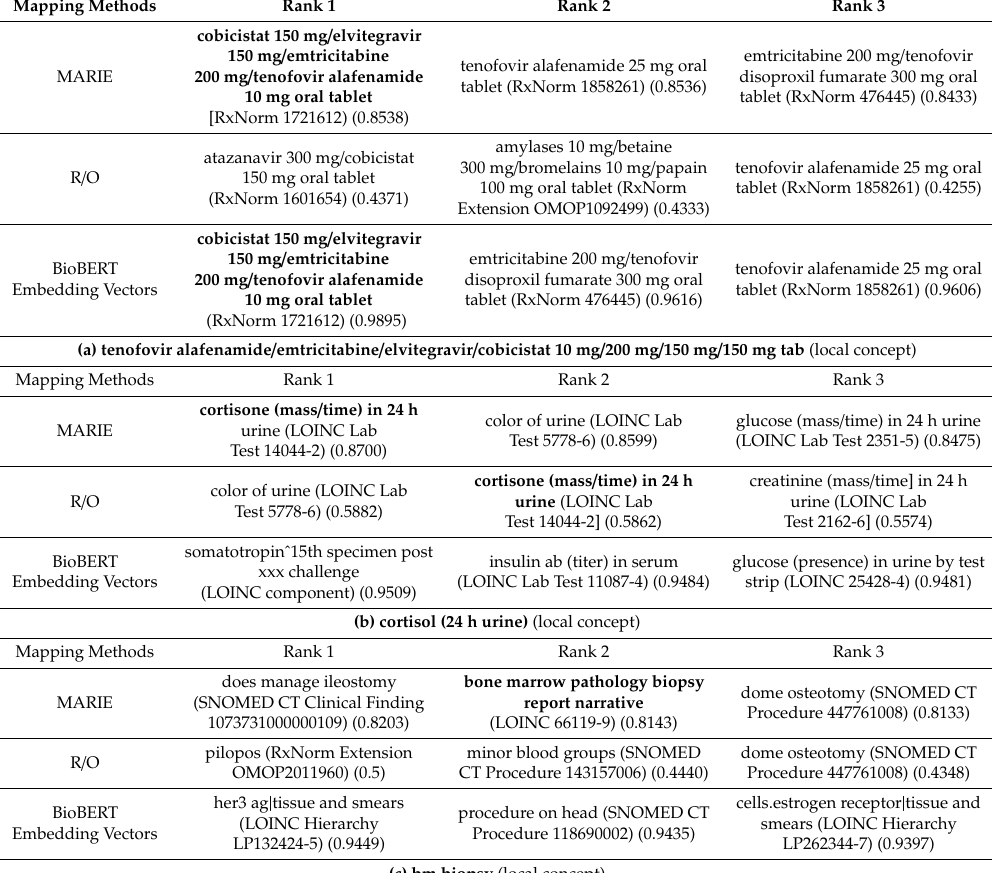
Table 2. Comparison of the top three mapped outcomes from MARIE, the R / O string matching method and embedding vector-based mapping. A bold and underlined term represents a correctly mapped term. (a) MARIE and the embedding vector-based method found the correct mapping for the input word to a target term in RxNorm, even though there was a word order discrepancy. (b) MARIE and the R / O string matching method found the correct mapping for the input word to a target term in LOINC, even when there were missing words between the mapping. (c) MARIE was even capable of finding a mapping missed by the other two methods, thereby correctly mapping to a term in